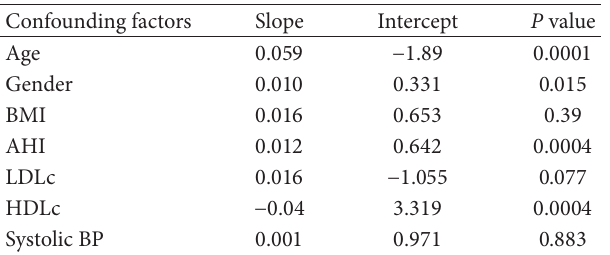
Table 2: Metaregressions statistics for evaluated confounding fac- tors.